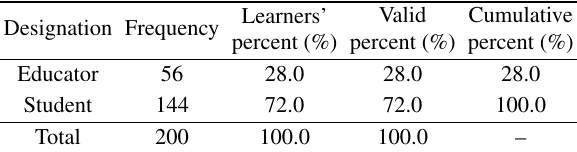
Table 3 Designation of participants.